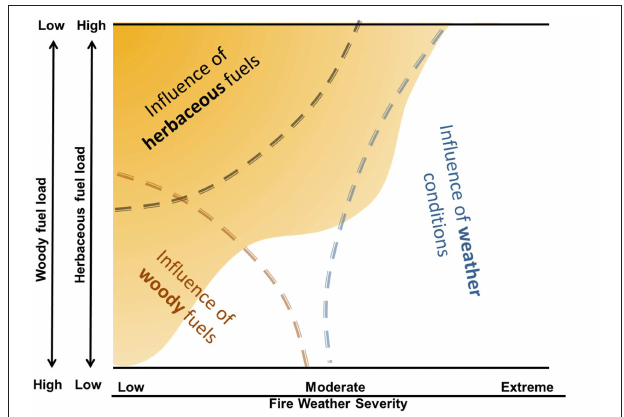
FIGURE 2 | A conceptual model of the interaction of herbaceous and woody fuels with fire weather severity. Fuel composition is displayed on the y-axis and fire weather condition is displayed on the x-axis. Low fire weather severity is characterized by high fuel moistures, high relative humidity, low temperature, and low wind speeds, while extreme fire weather is characterized by the opposite conditions. As woody fuel loading or fine fuel loading increases, fuel packing ratios become more optimal, fuel continuity increases, and less severe fire weather is required for large wildfires. Annual grasses produce fine fuels, represented by the area in yellow in the upper left, that can fill interspaces between native fuels (shrubs and grasses). Extreme fire weather conditions, which are projected to increase in the future, can override the influence of fuel loads and continuity. Figure modified from Strand et al. (2014).